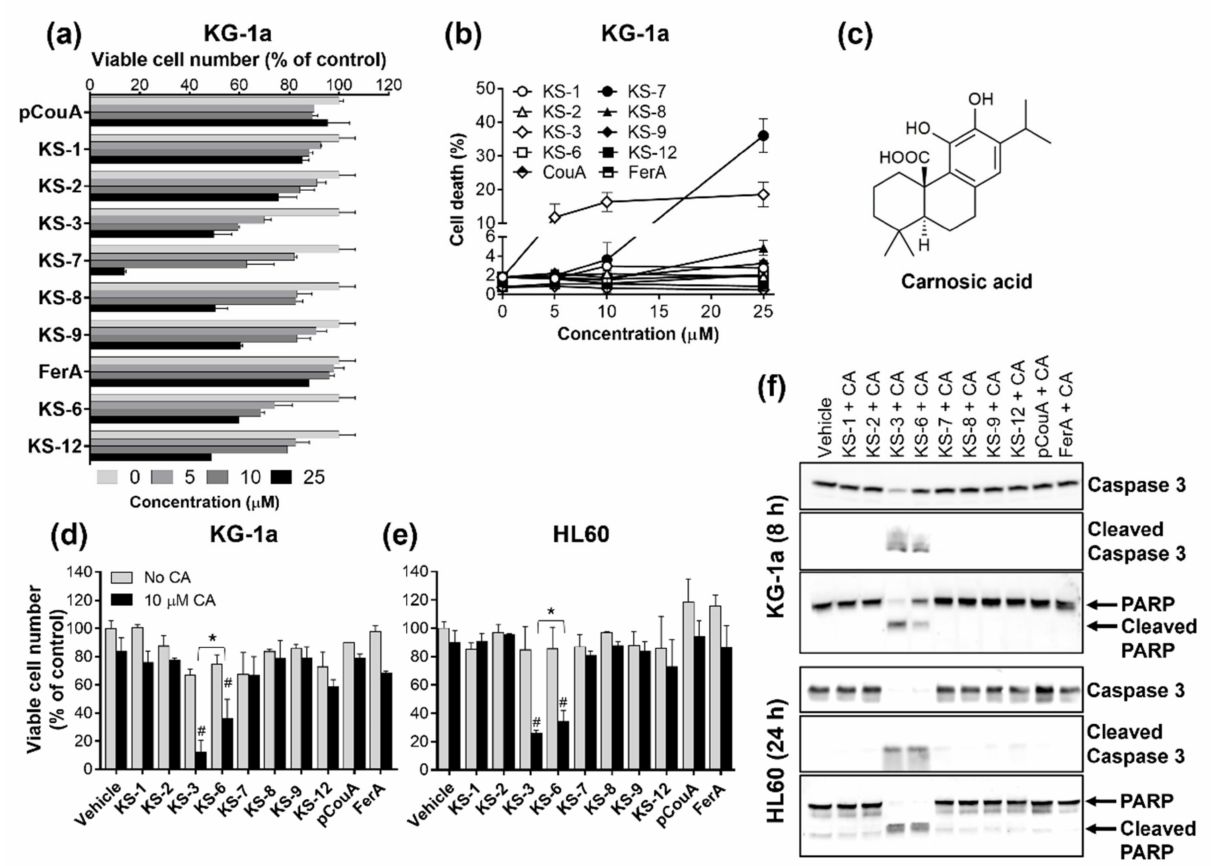
Figure 2. The hydroxycinnamic acid derivatives methyl 4-hydroxycinnamate (KS-3) and methyl ferulate (KS-6), but not their chemical analogs, synergize with carnosic acid in inducing cytotoxicity to AML cells. KG-1a and HL60 cells were treated with 5 µ M para-coumaric acid (pCouA), ferulic acid (FerA) or their derivatives, 10 µ M carnosic acid (CA), alone or in combination followed by the Trypan Blue exclusion assay (72 h; ( a , b , d , e )) or Western blot analysis (8 h and 24 h; ( f )). ( a , b ) Effects of the indicated compounds on the number of viable cells ( a ) and the percent of cell death ( b ) in KG-1a cell cultures. ( a , b ) The data are the means ± SD ( n = 3). ( c ) The molecular structure of carnosic acid. ( d , e ) Effects of the indicated compounds on the number of viable cells of KG-1a ( d ) and HL60 ( e ) cells. ( d , e ) The data are the means ± SD ( n = 3–6). *, p < 0.05, significant difference between the KS-3+CA and KS-6+CA groups. #, p < 0.05, effect of a combination vs. sum of the effects of single agents ( n = 6); Student’s t test. ( f ) Caspase-3 and PARP cleavage in KG-1a and HL60 cells following treatment with the indicated combinations of pCouA, FerA or their derivatives, together with